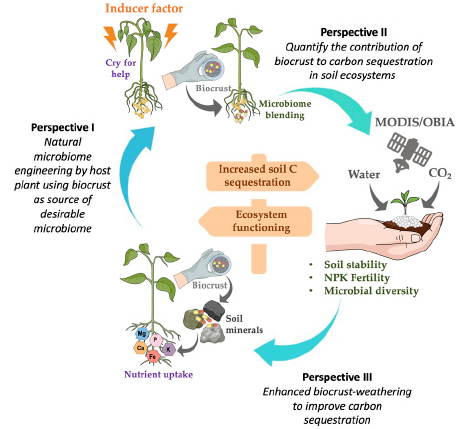
Figure 3. Proposal perspectives: biocrust applications in agriculture and in a new environment. The link between soil processes, microbiome, ecosystem services, weathering, and soil monitoring per- spectives. The arrows indicate the relationship between soil–plant processes and biocrusts. The yel- low arrow indicates the impact of the soil perspectives on regulating and provisioning ecosystem functioning and C sequestration.